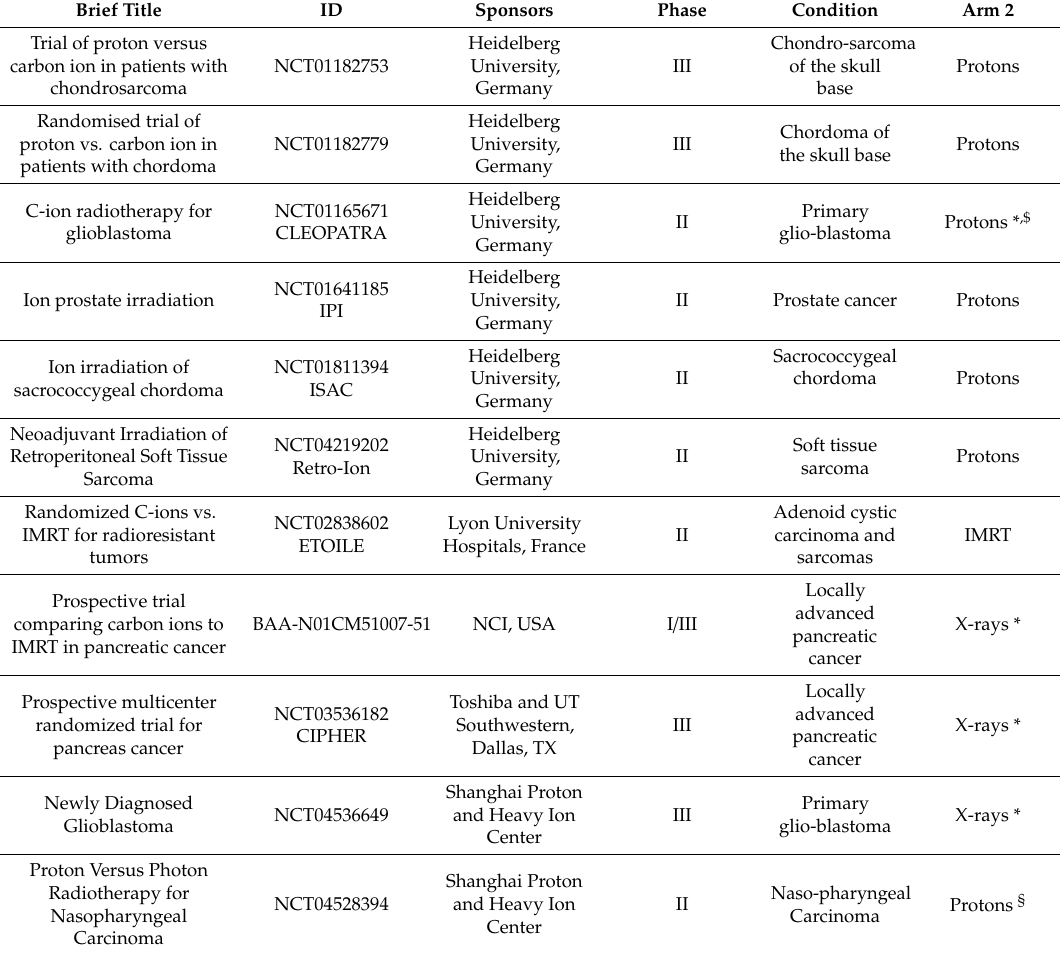
Table 1. Ongoing randomized clinical trials comparing C-ions to either protons or photon